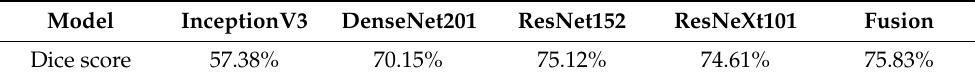
Table 2. Dice scores for tumor segmentation.